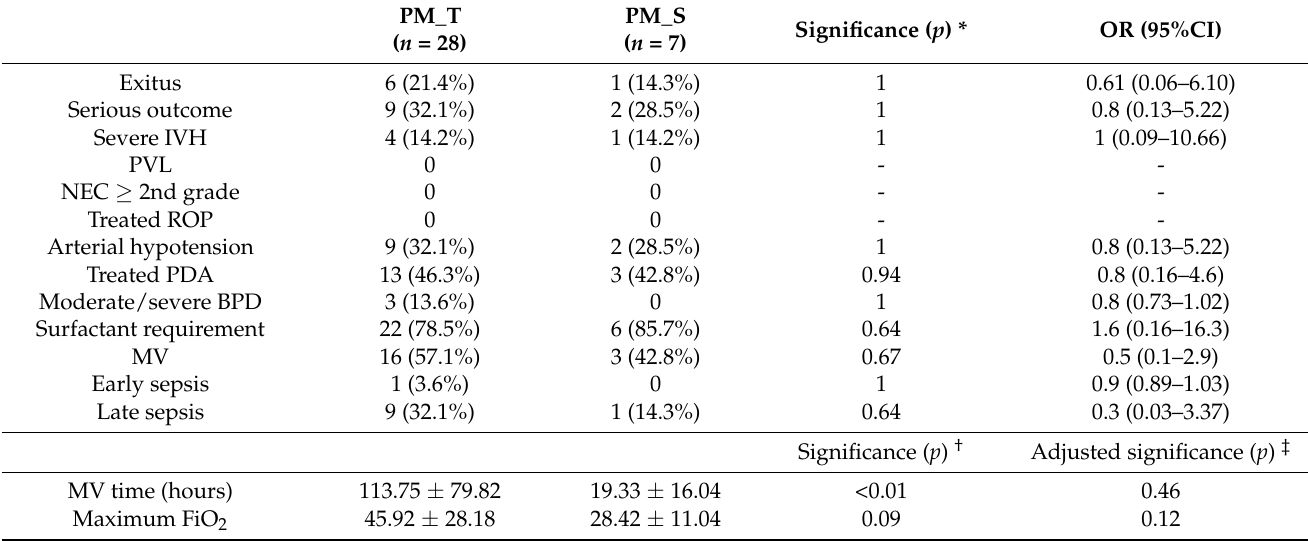
Table 6. Comparison of the population with partial maturation by place of